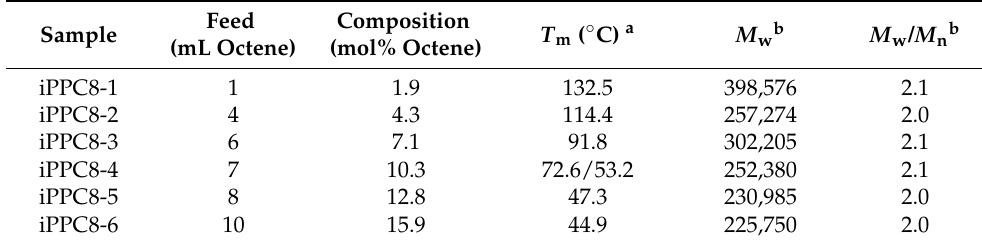
Table 1. Feed (mL octene) and copolymer composition (mol% octene), melting temperature of as-prepared samples ( T m ), molecular mass ( M w ), and dispersity ( M w / M n ) of iPPC8 copolymers